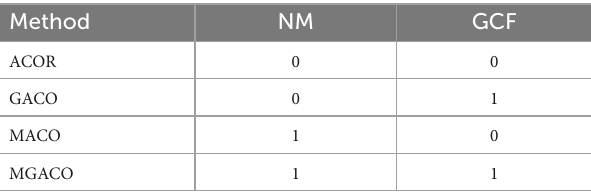
indicate that MGACO has superior final convergence accuracy than AOCR, and the convergence curves for F9, F24, and F25 also demonstrate that MGACO converges more rapidly than